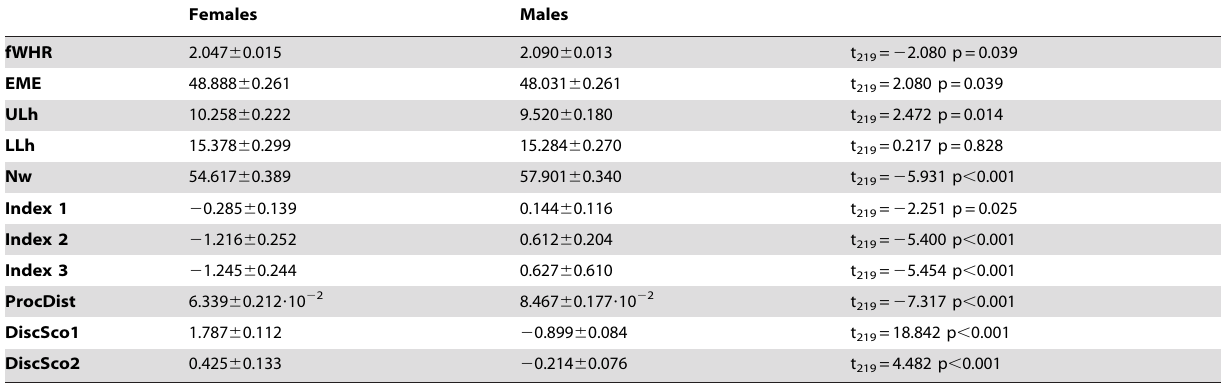
Table 1. Summary